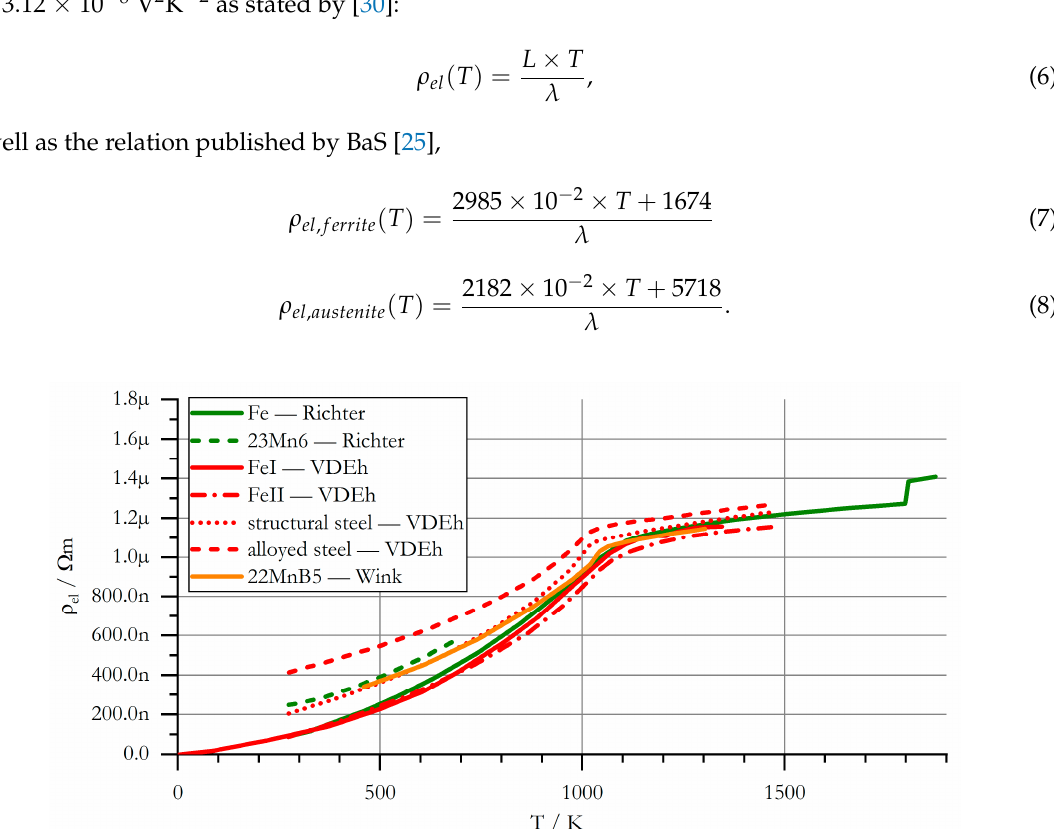
Figure 8. Specific electric resistance of 22MnB5, literature data.